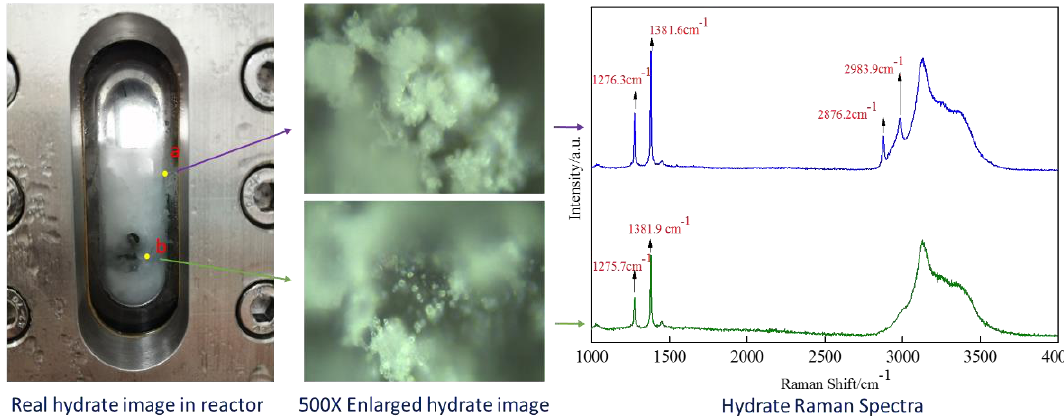
Figure 14. Raman spectra of hydrates formed from CP-CO 2 system at different